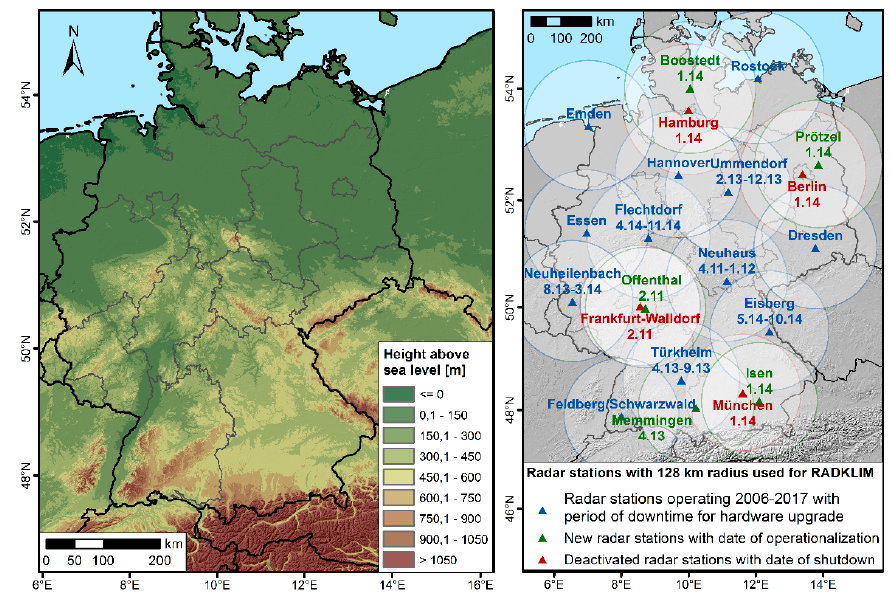
Figure 1. Height above sea level (m) of Germany based on a SRTM Digital Elevation Model ( left map ) and German radar station network with 128 km radius as used for RADKLIM ( right map ).